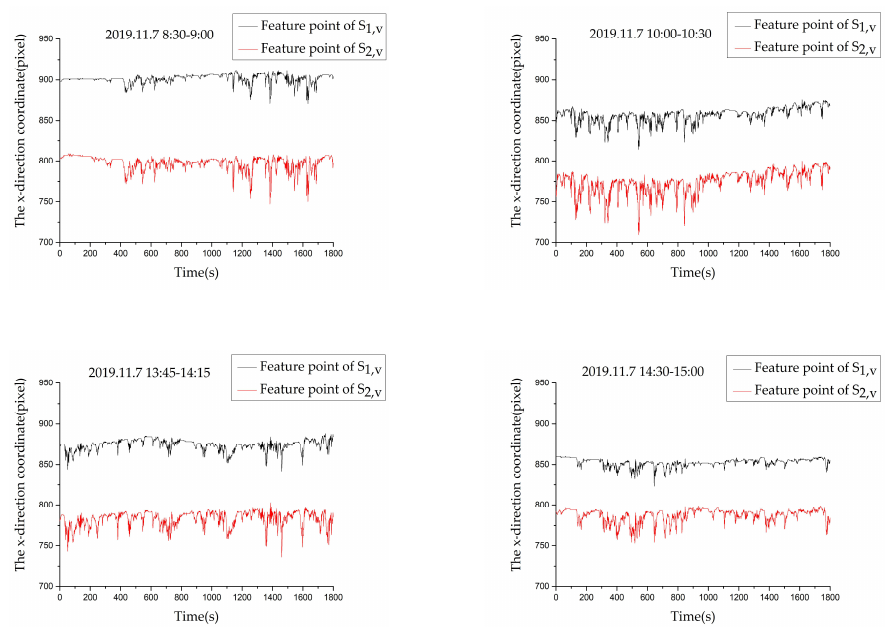
Figure 5. The coordinate change of feature points of S 1,v , S 2,v in the x axis direction in the videos in the first four monitoring periods.